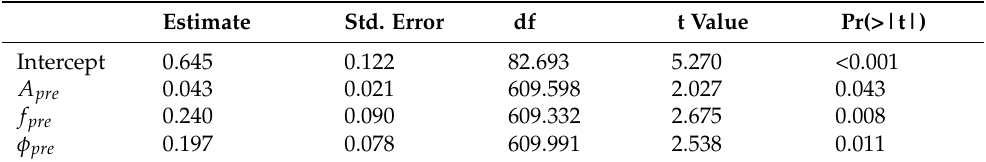
Table 1. Estimates for main effects of a mixed linear model predicting the magnitude of the eyebrow peak in a segment based on the parameters of the sinusoidal function for the pre-peak region, with a window size of 19 frames ( ≈ 630 ms).